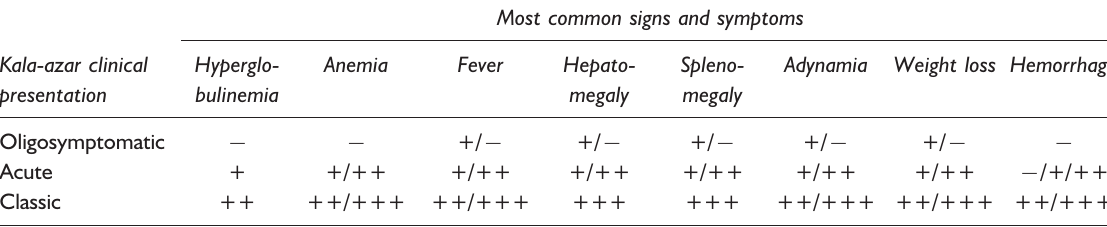
Table 2 Kala-azar clinical presentations and the most common signs and symptoms Most common signs and